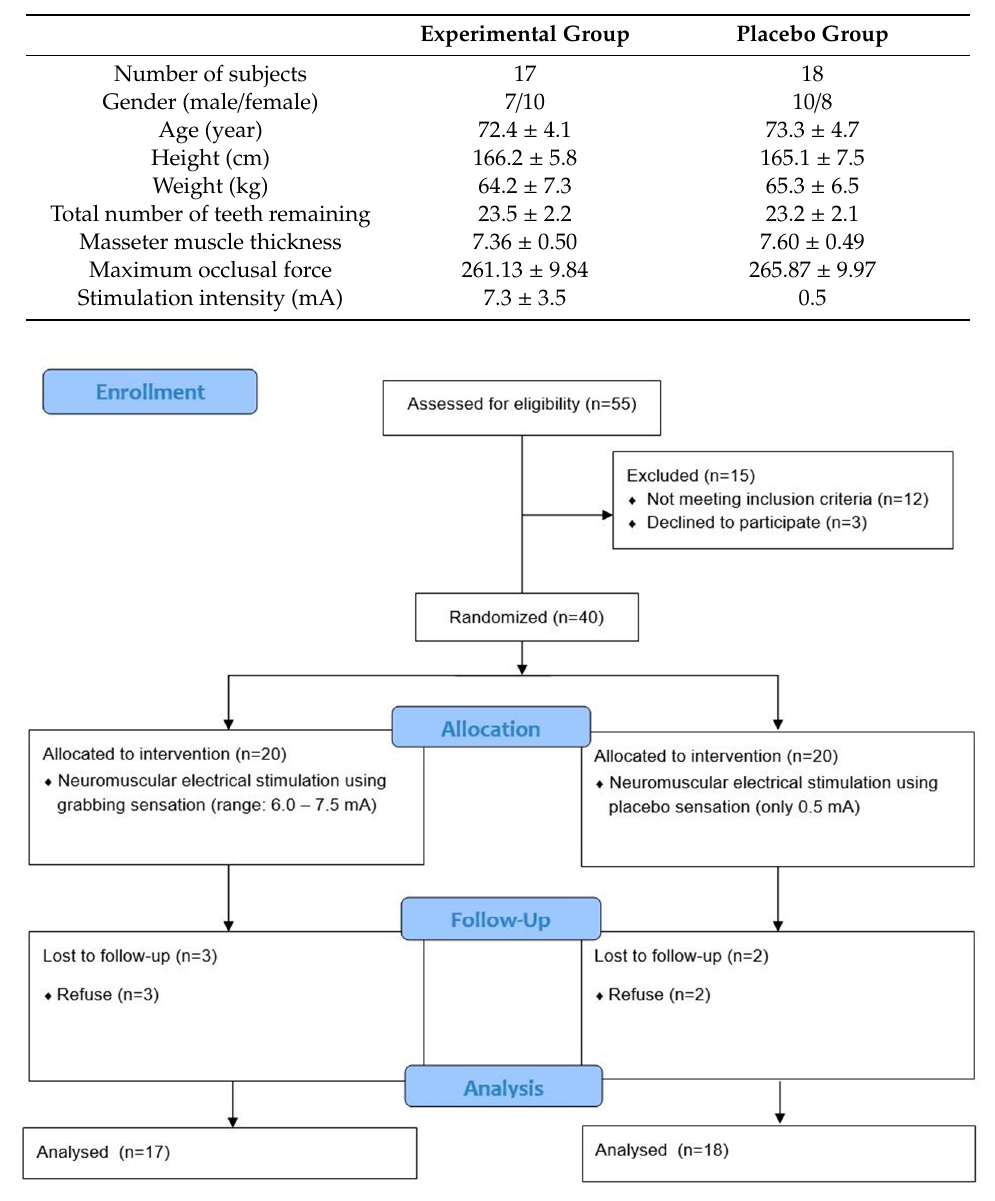
Table 1. General characteristics of the subjects.